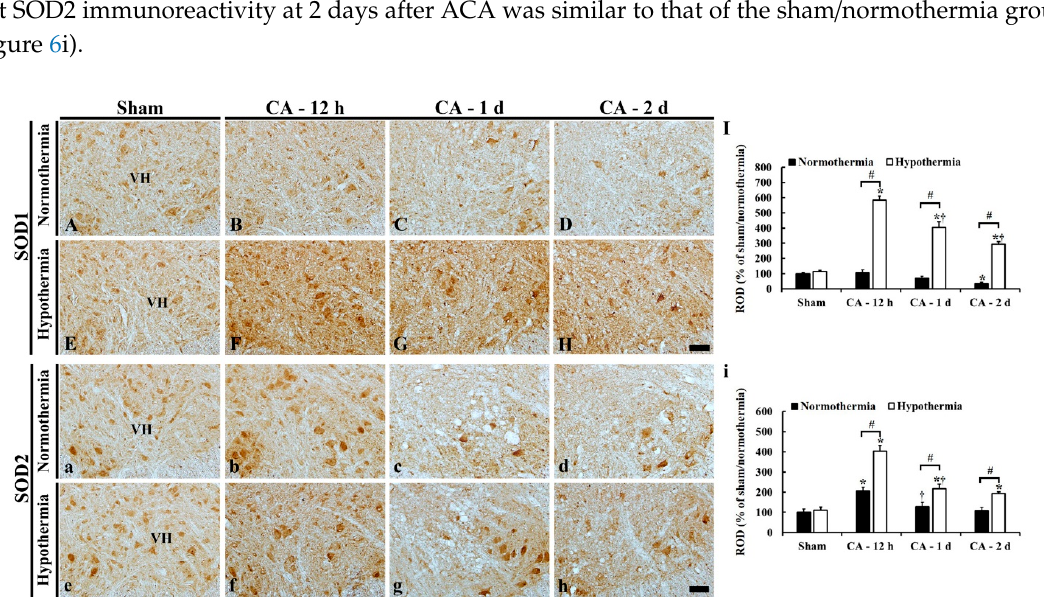
Figure 6. Immunohistochemistry of SOD1 ( A – H ) and SOD2 ( a – h ) in the lumbar ventral